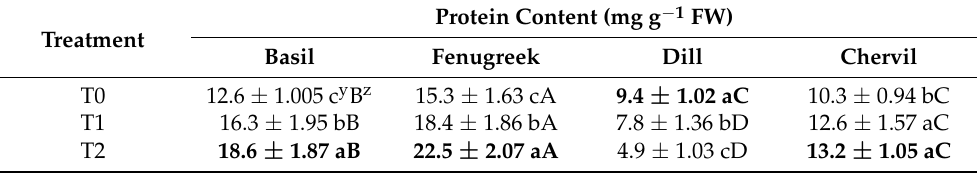
Table 6. Protein content (mg g − 1 FW) of basil, fenugreek, dill, and chervil microgreens cultivated under three light-emitting diode (LED) lamp spectra. The best light treatment, for each plant species, is